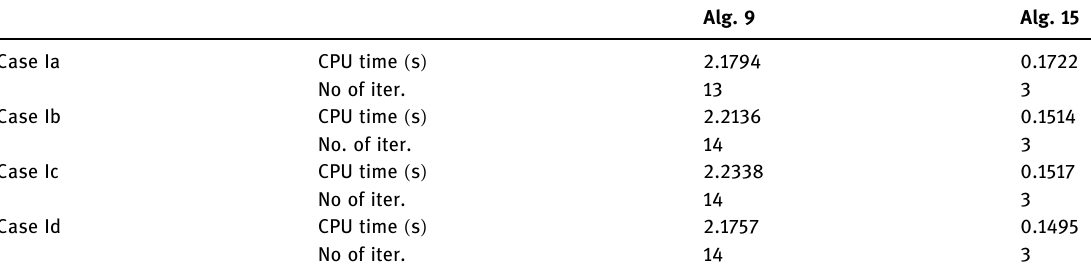
Table 1: Numerical results for Example